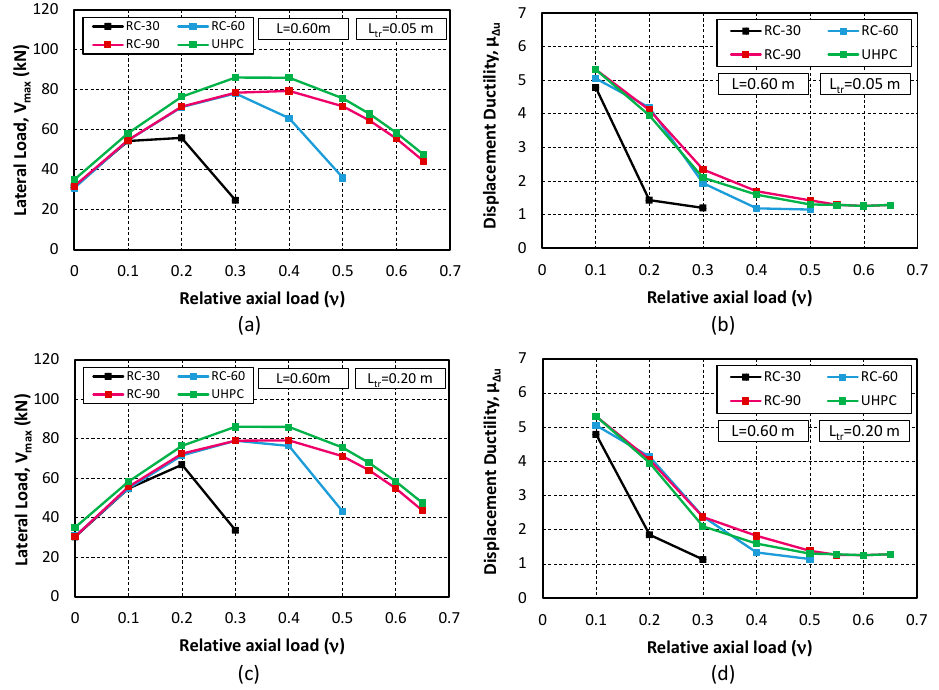
Figure 14. Maximum load and displacement ductility in the specimens with a main zone length L of 0.60 m and several transition zone lengths L tr (Phase 4): ( a ) lateral load–relative axial load for L tr = 0.05 m; ( b ) displacement ductility–relative axial load for L tr = 0.05 m; ( c ) lateral load–relative axial load for L tr = 0.20 m; ( d ) displacement ductility–relative axial load for L tr = 0.20 m.